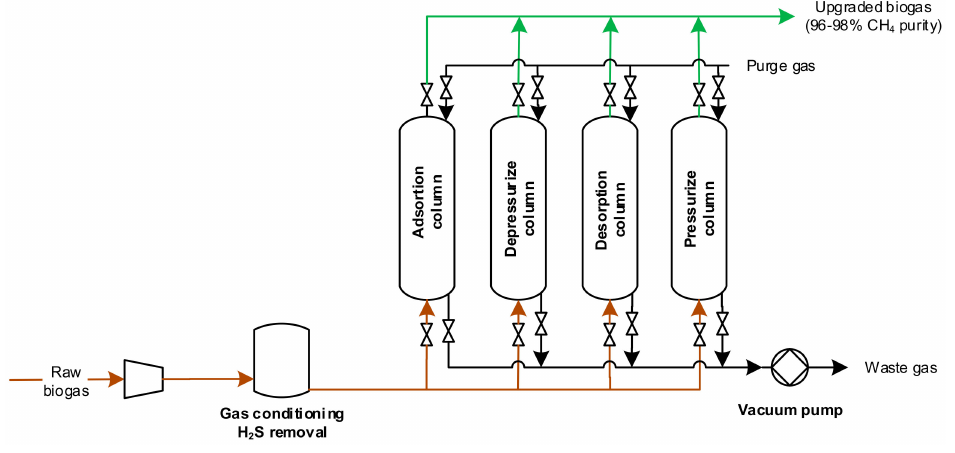
Figure 8. Biogas upgrading by pressure swing adsorption (PSA). Adapted from Muñoz et al. [103].